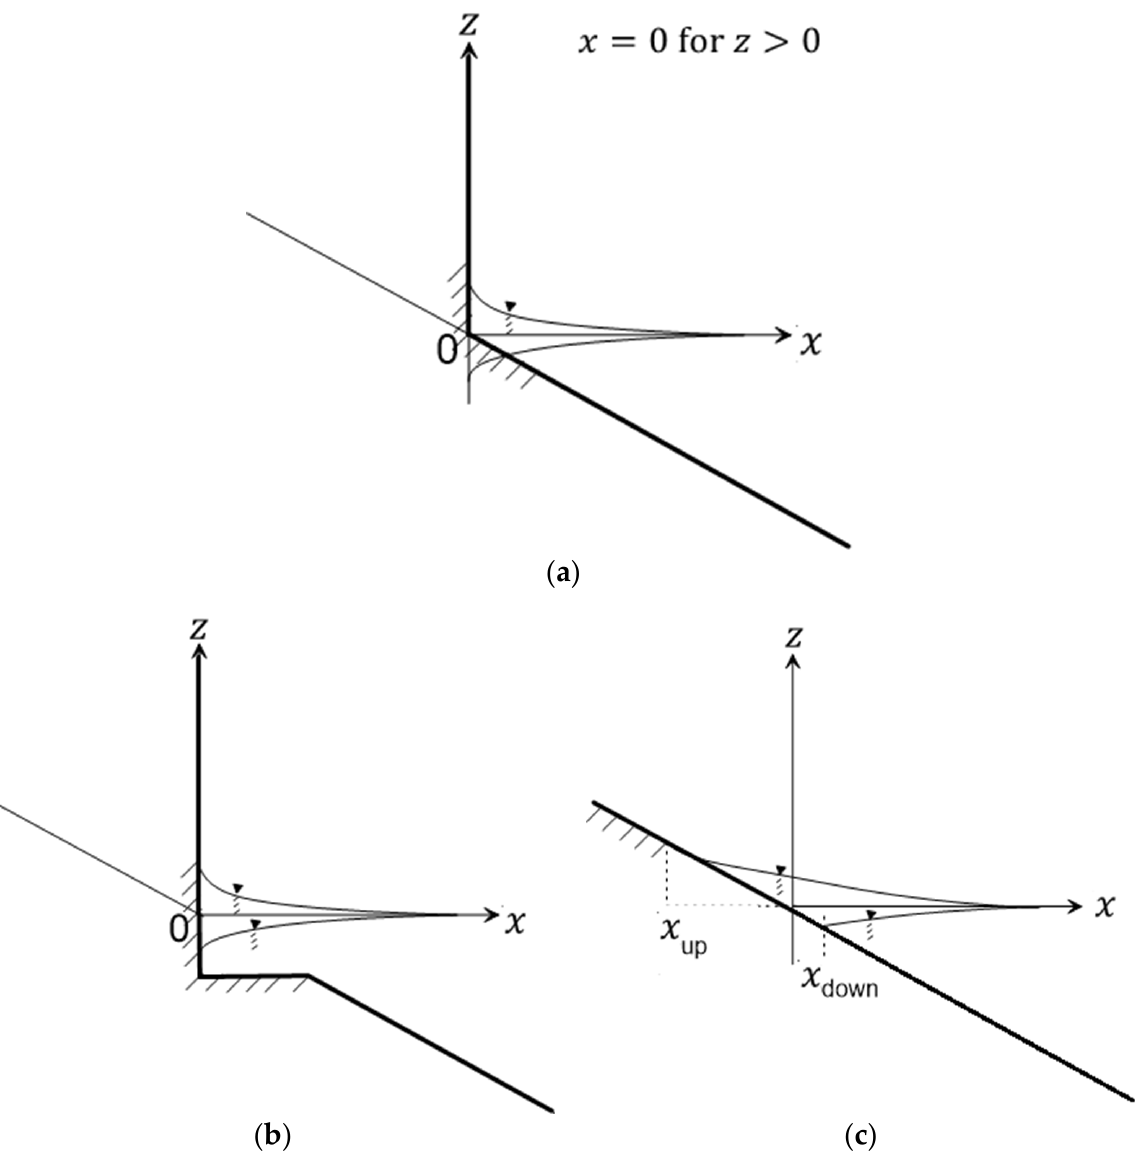
Figure 1. Folded, excavated, or sloped bed boundaries for edge waves: ( a ) vertical wall at shoreline; ( b ) excavation around shoreline; ( c ) uniformly sloped bed.